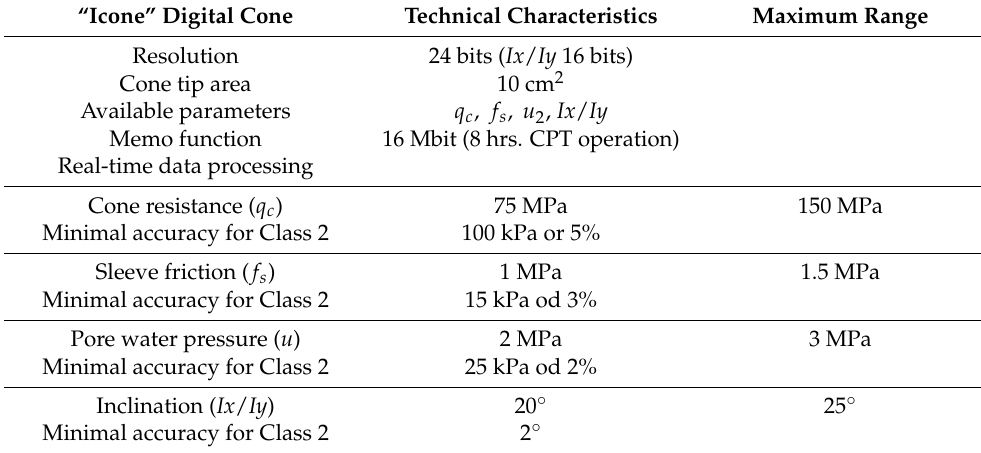
Table 1. Technical specifications of the CPT Icone digital cone.